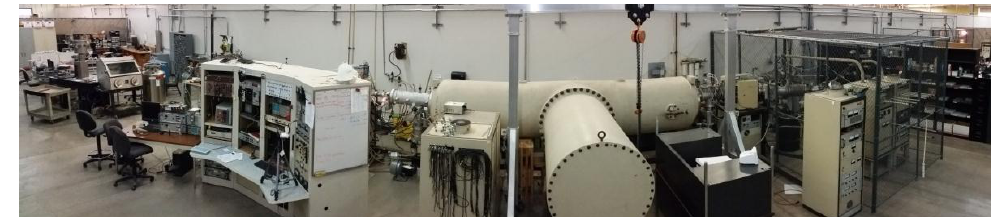
Figure 1. The picture of the ion accelerator.